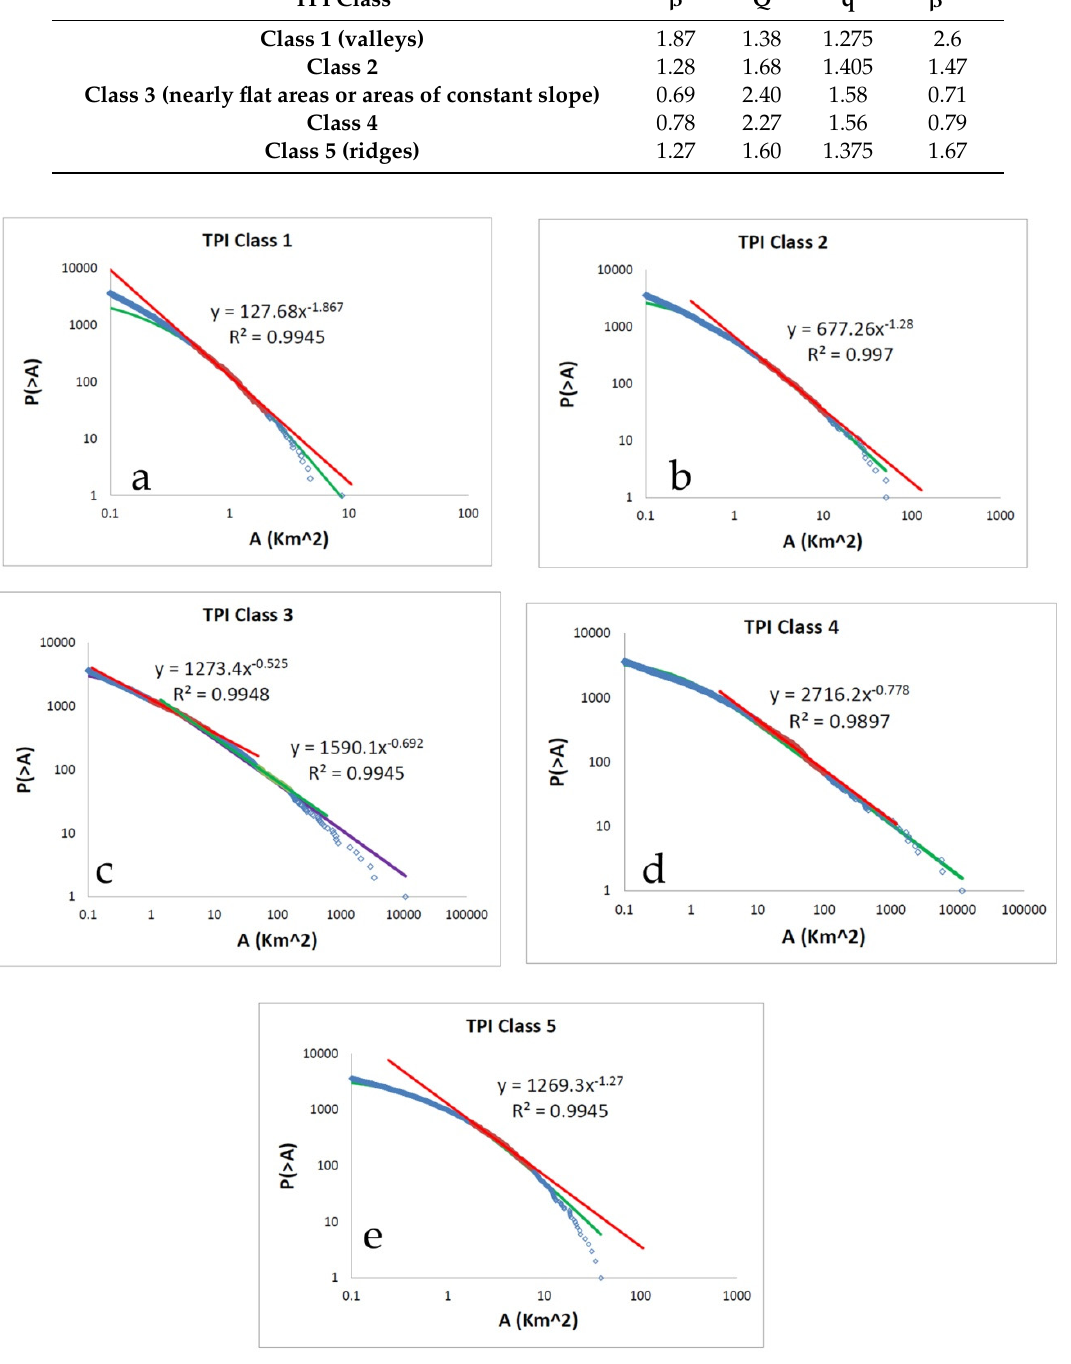
Figure 8. The drainage distribution for the five classes defined in Greece according to TPI values. A power law fitting is presented along with the Q-exponentials. The scaling exponent β and the Q values as presented in Table 2 (see text). Table 2. The power law exponent β , the Q and q non extensive parameters and the β cal value as estimated for each TPI class.